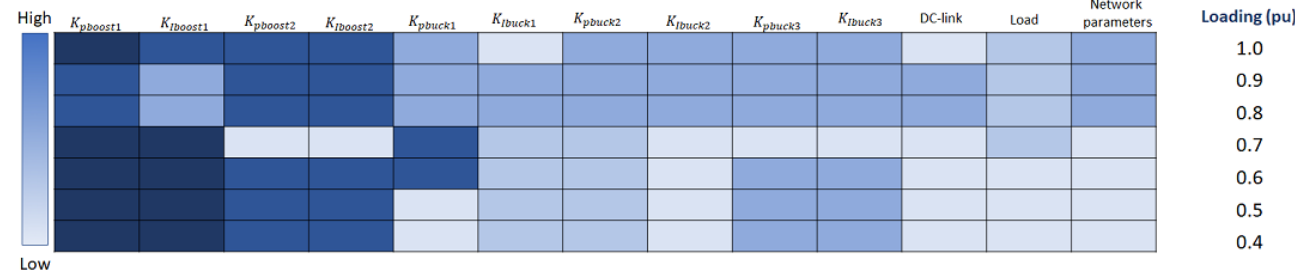
Figure 13. Heatmap for ranking critical parameter for resonance . Table 7. Influential parameters identified using the different sensitivity method (oscillation stabil- ity).